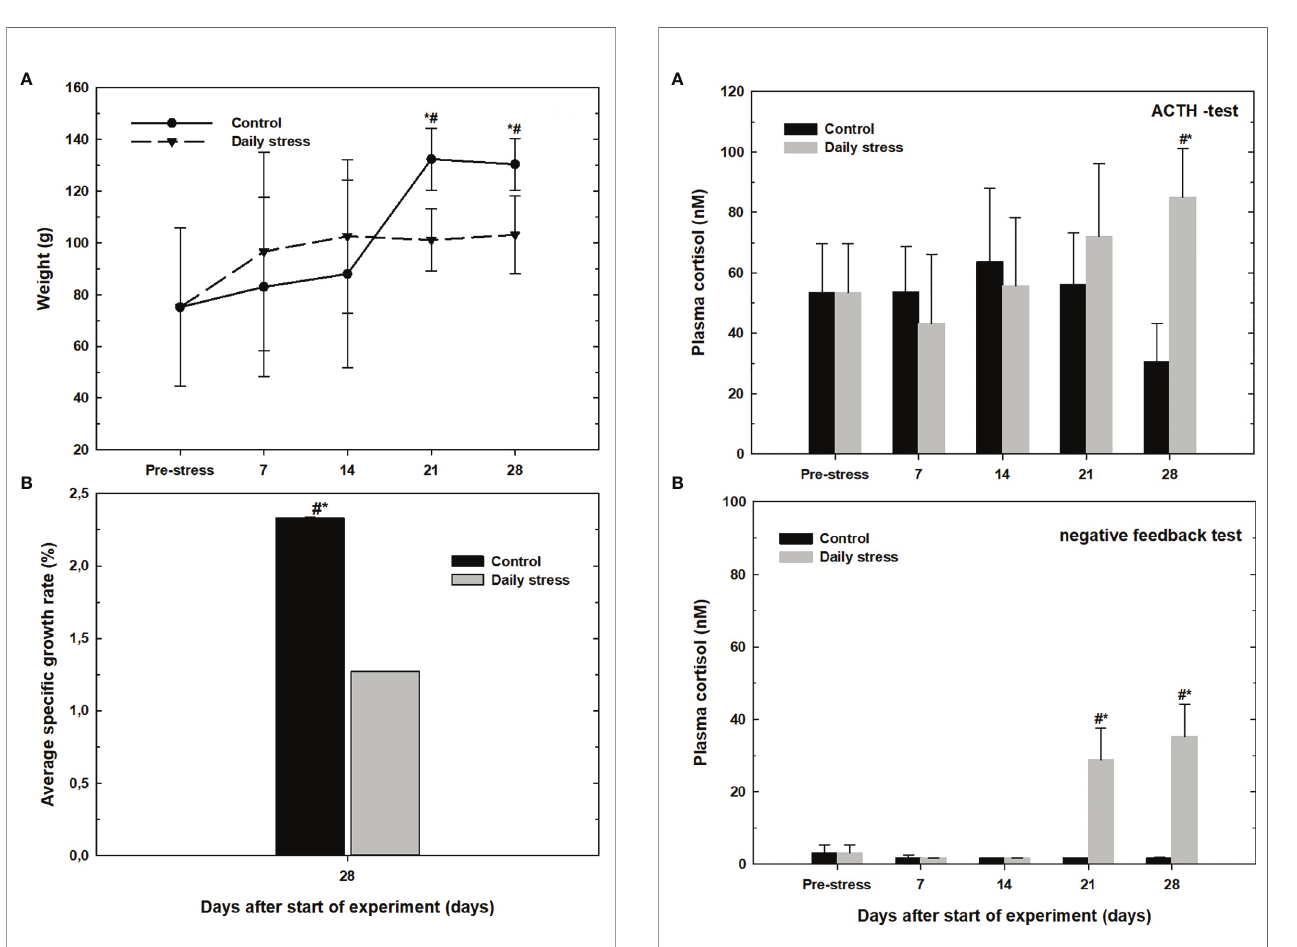
FIGURE 7 | Plasma cortisol levels (mean ± SD, n=12) in the control group (black bars) and daily stress group (grey bars) in lump fi sh during 28 days of exposure (n=12) following intraperitoneal injection with either (A) adrenocorticotropic hormone (ACTH 45 µg mL -1 , 0.5 mL kg -1 ) or (B) negative sensitivity test; phosphate buffered saline (PBS; 0.5 mL kg -1 ). All fi sh were injected 24 h earlier with dexamethasone (DEX; 1 mg kg -1 in ethanol: PBS; 1:3; 1 µg L -1 ). # indicates signi fi cant difference between groups at the same sampling day at 95% con fi dence level, * indicates signi fi cant difference from the pre-stress level at 95% con fi dence